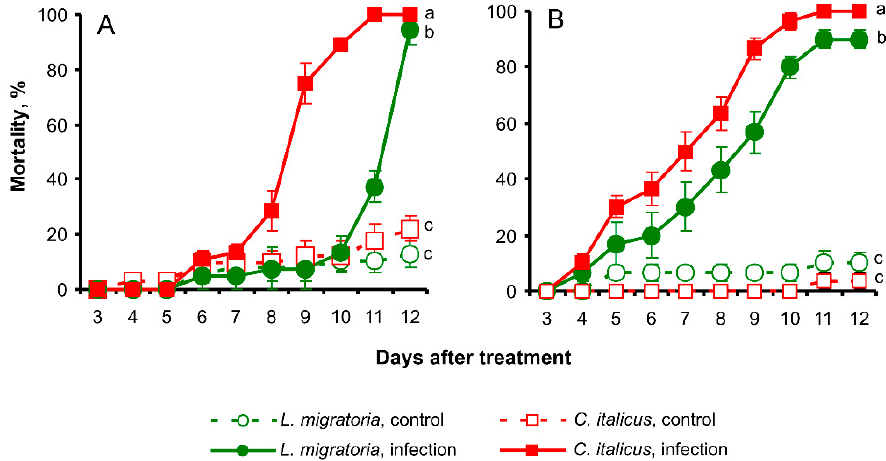
Figure 4. Mortality dynamics of L. migratoria and C. italicus nymphs after immersion in an M. robertsii ( A ) or B. bassiana ( B ) suspension (10 7 conidia/mL). Different letters indicate significant differences in mortality dynamics (log-rank test: χ 2 > 6.8, df = 1, p < 0.009).